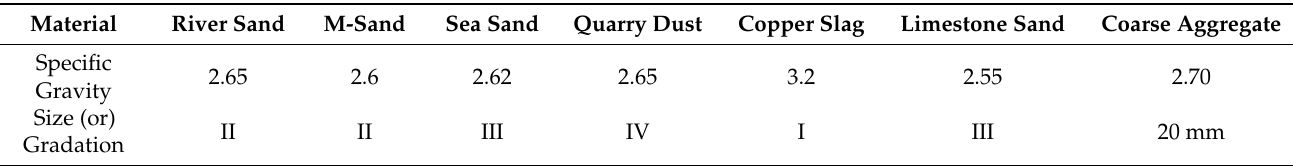
Table 3. Physical properties of